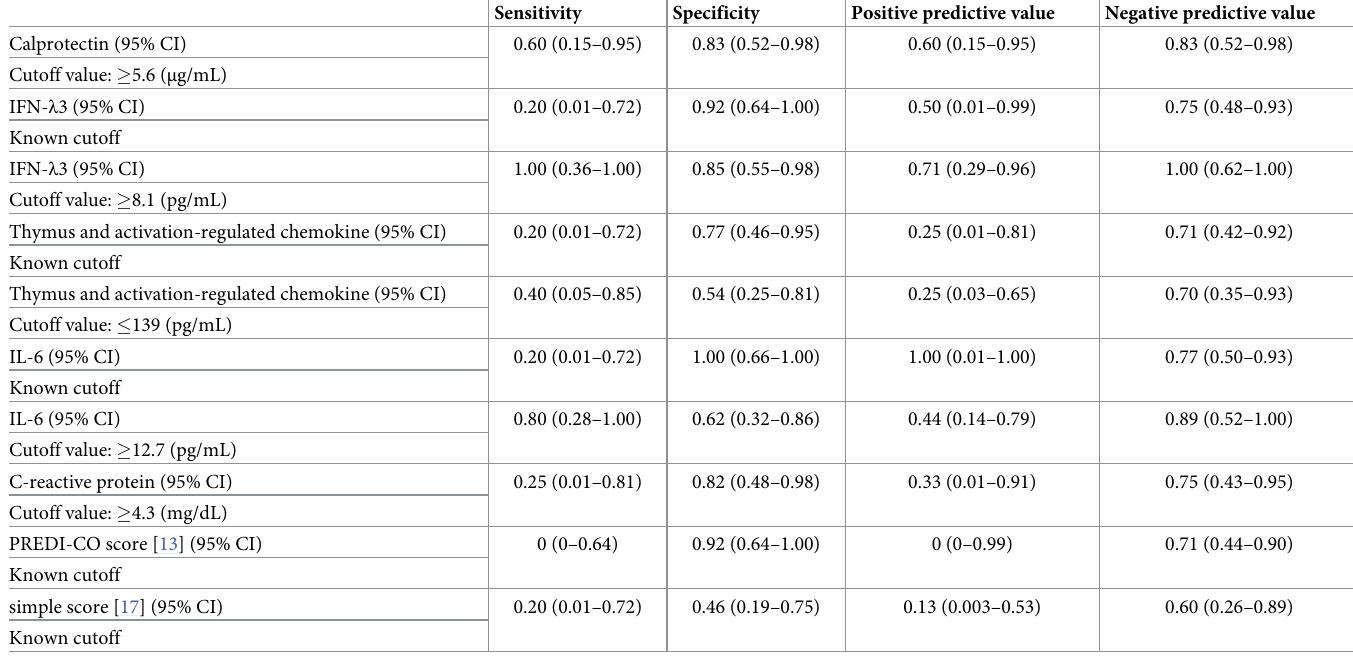
Table 2. Predictive ability of each biomarker and prediction score for future oxygen